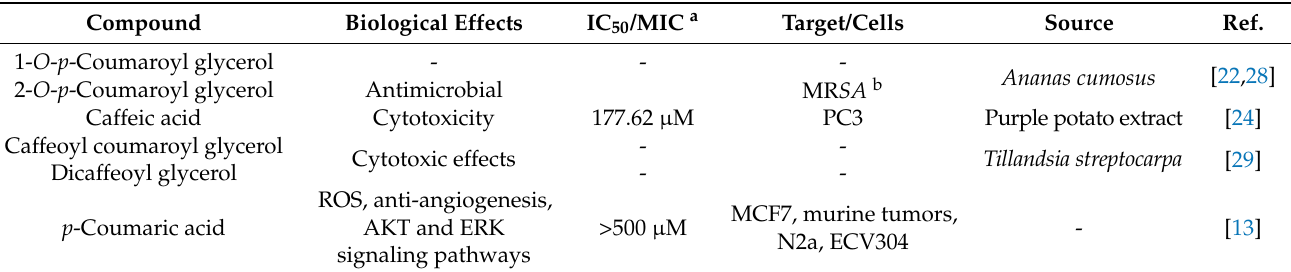
Table 4. Active phenolic compounds identified in fraction 4